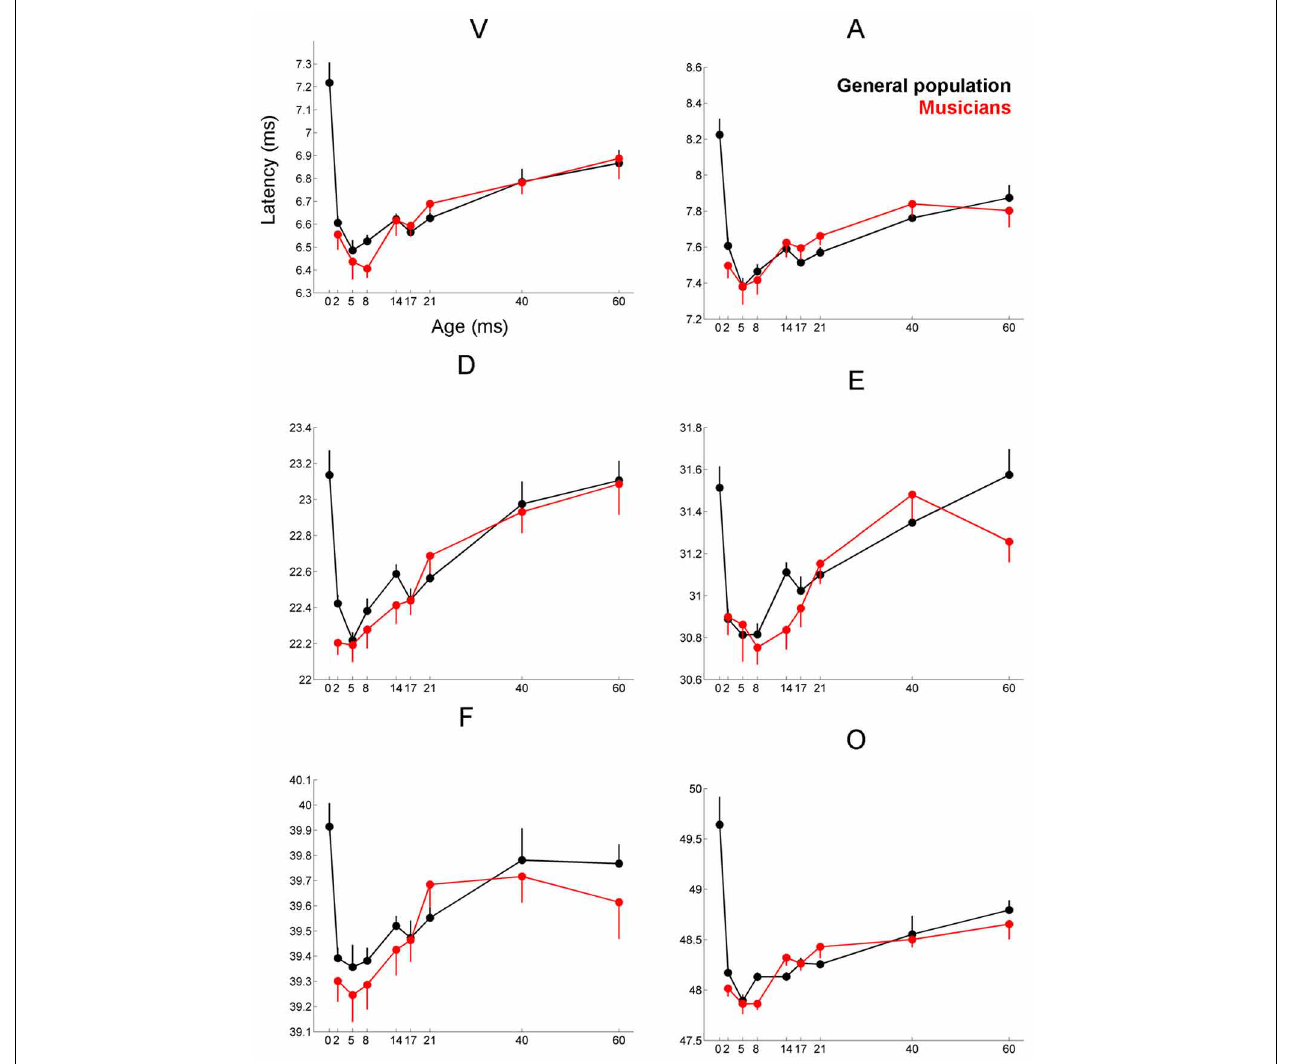
FIGURE 3 | Age-dependent changes in latency for the six characteristic peaks of the cABR plotted for the musicians (red) and general population (black). Error bars represent one standard error of the mean (mean + 1 S.E. for the general population and mean − 1 S.E. for the musicians). The value reported on the x-axis represents the youngest age for each group, e.g., 5 represents 5–8 and 8 represents 8–14. The infant group was not factored into the analysis but is plotted here for reference. Across all peaks, the minimum latency occurs around age 8, after this point the